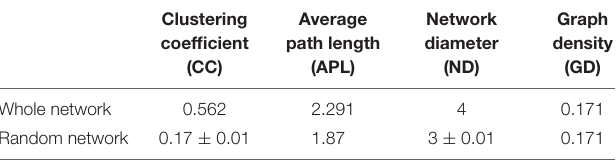
TABLE 2 | Topological properties of co-occurring